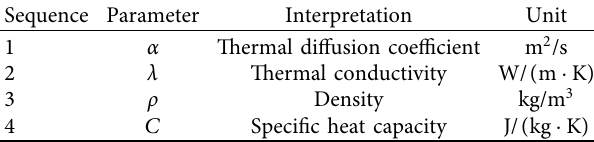
Table 3: Parameter definition in the formula. Sequence Parameter